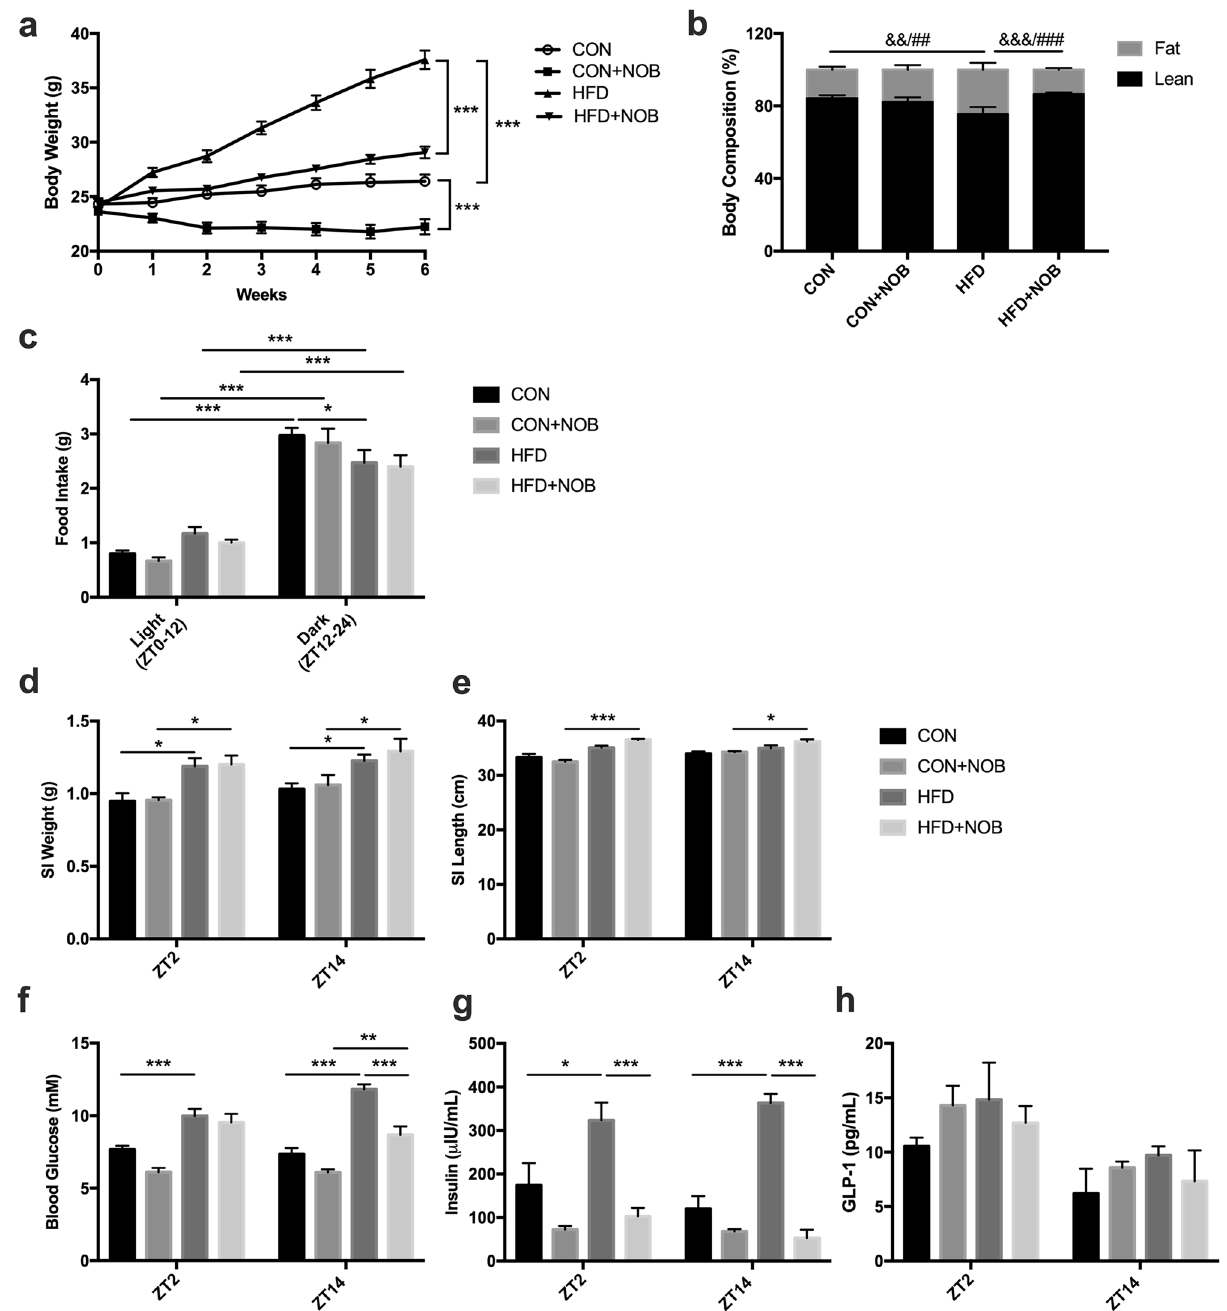
Figure 3. Nobiletin improves metabolic parameters following HFD-feeding in mice. ( a ) Body weight, ( b ) body composition, and ( c ) 12-h light/12-h dark food intake in control (CON)- and high-fat diet (HFD)-fed mice with and without nobiletin (NOB) supplementation. Small intestinal ( d ) weight and ( e ) length, and 4-h fasting ( f ) blood glucose, ( g ) plasma insulin, and ( h ) plasma GLP-1 at ZT14 in CON- and HFD-fed mice with and without NOB supplementation. n = 6; *p < 0.05 **p < 0.01 ***p < 0.001; ## p < 0.01 ### p < 0.001 comparing %fat composition and && p < 0.01 &&& p < 0.001 comparing %lean